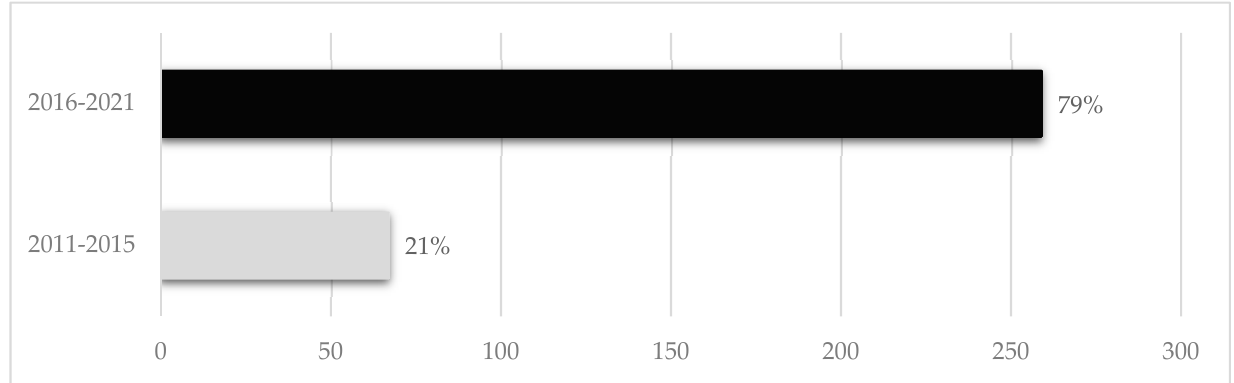
Figure 1. Difference in the percentage of publications.